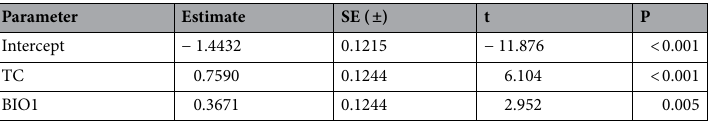
Table 1. Parameters of the best-fitting multiple linear regression model assessing ocelot density in the Amazon biome. TC percent tree cover, BIO1 annual mean